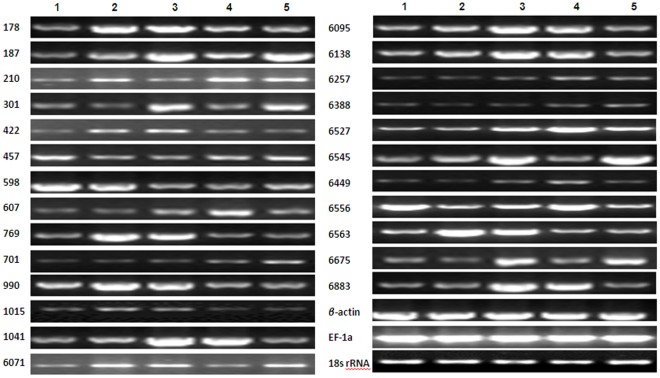
Gene expression analysis of differentially expressed proteins from the proteomics assay by semi-quantitative RT-PCR.Genes encoding the 26 different proteins listed in Table 5 were analyzed. Semi-quantitative RT-PCR was performed using gene-specific primers, and β-actin, EF-1a and 18S ribosomal RNA genes were used as internal controls.